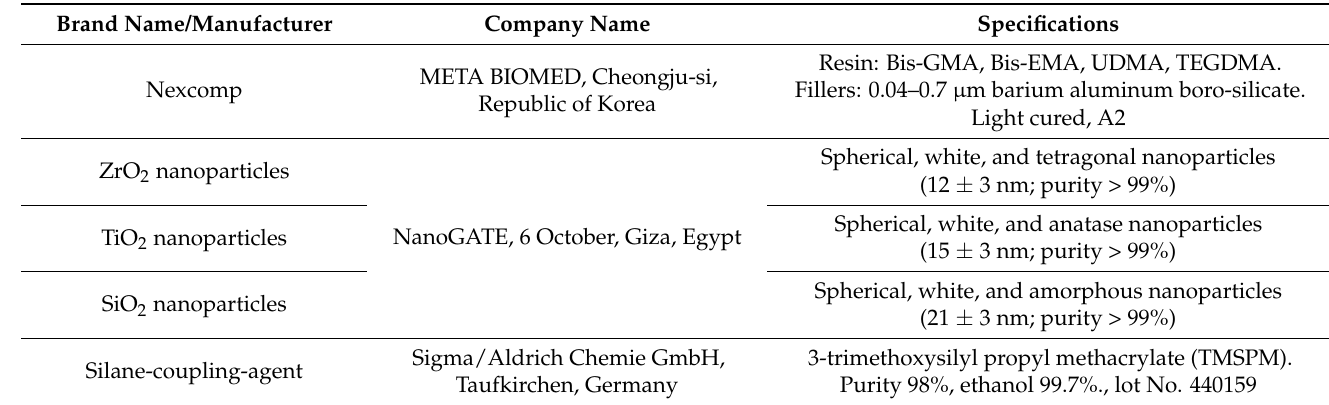
Table 1. List of materials used in the current